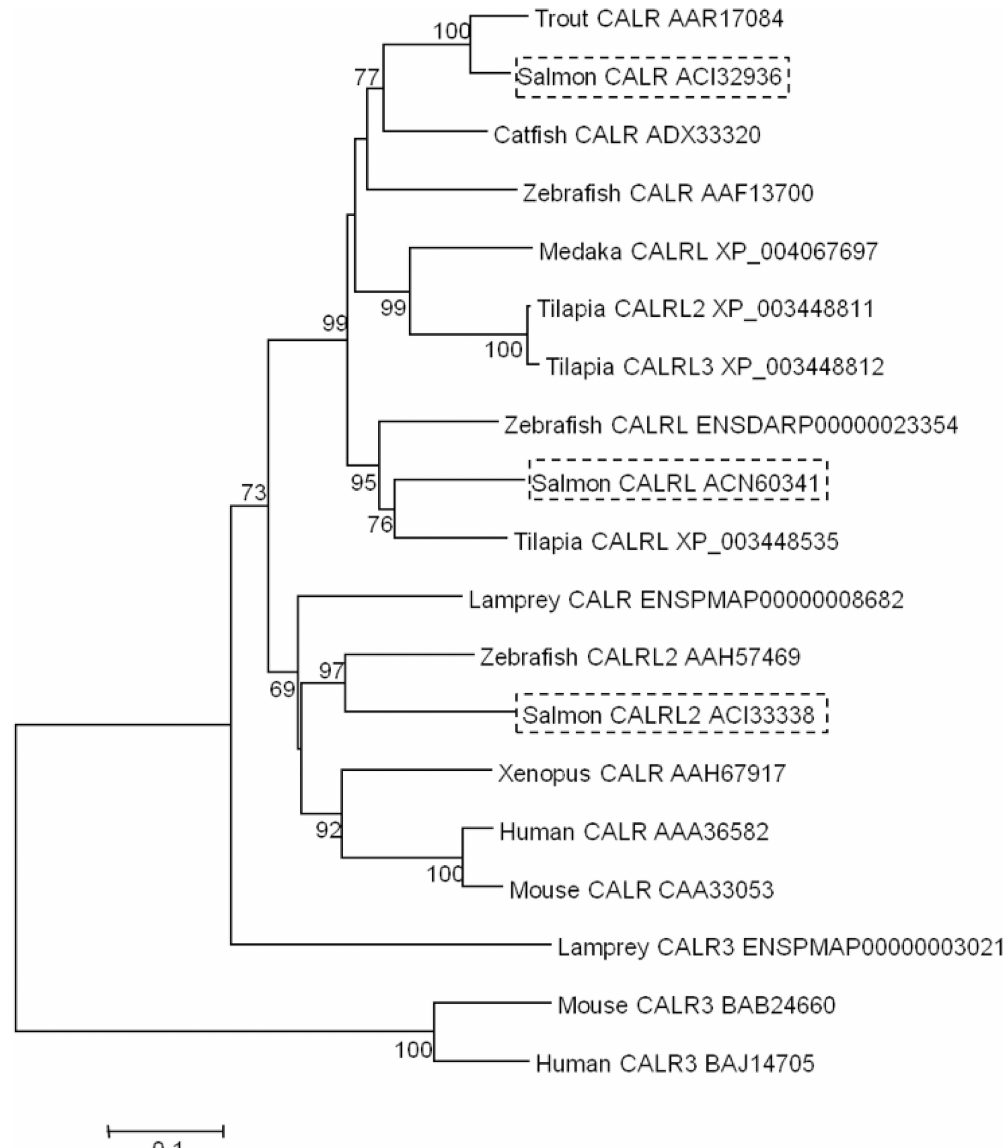
Fig 3. Phylogenetic trees showing the evolutionary relationship of the calreticulin family of proteins in vertebrates, rooted by the mammalian calreticulin-3. The tree was used to name the calreticulin isoforms of Salmo salar . The tree was constructed using multiple alignments of the vertebrate calreticulin. The neighbour- joiningmethod in MEGA 5 [37] was selected. The percentage of replicate trees in which the associatedtaxa clusteredtogether in the bootstraptest (10,000 replicates)is shownnext to the branches [40]. The salmon sequencesare boxed. Each entry is describedby the species common name and protein name, followedby the Genbank or Ensemblaccession